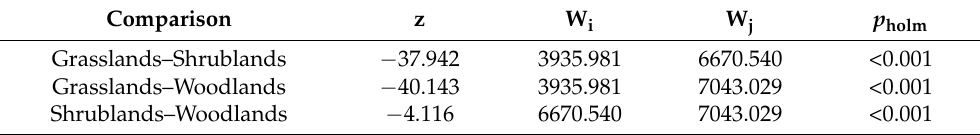
Figure 3. Boxplot of dNBR pre-post values in burned and unburned grasslands (GL), shrublands (SL), and woodlands (WL). The boxes show the interquartile range, horizontal bars show median values, and vertical bars show the top and bottom 25% quartiles. Table 3. Dunn’s post hoc comparison for dNBR pre-post values in the burned area.